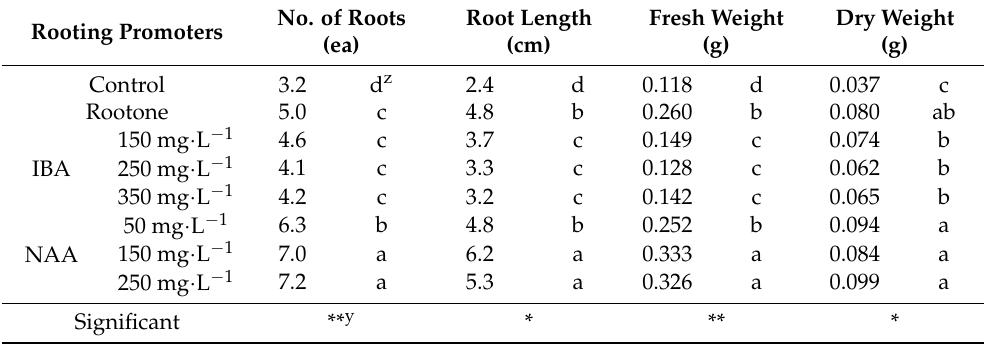
Table 2. Characteristics of root growth as affected by rooting promoters at 70 days after cutting Rhododendron micranthum Turcz.